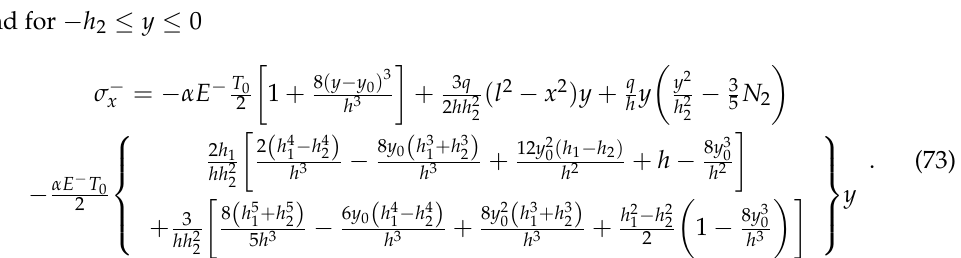
/ 20 E T q α − = . Figure 10. The total stress when E + = 2 E − and α E − T = 0 0 / q